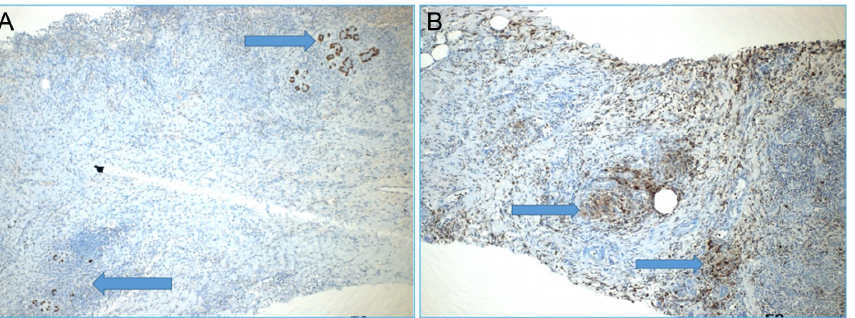
Figure 6. A,B. Immunohistochemically, P63 positive normal breast ducts (A—blue arrows) and granuloma structures formed by CD-68 positive epithelioid histiocytes (B—blue